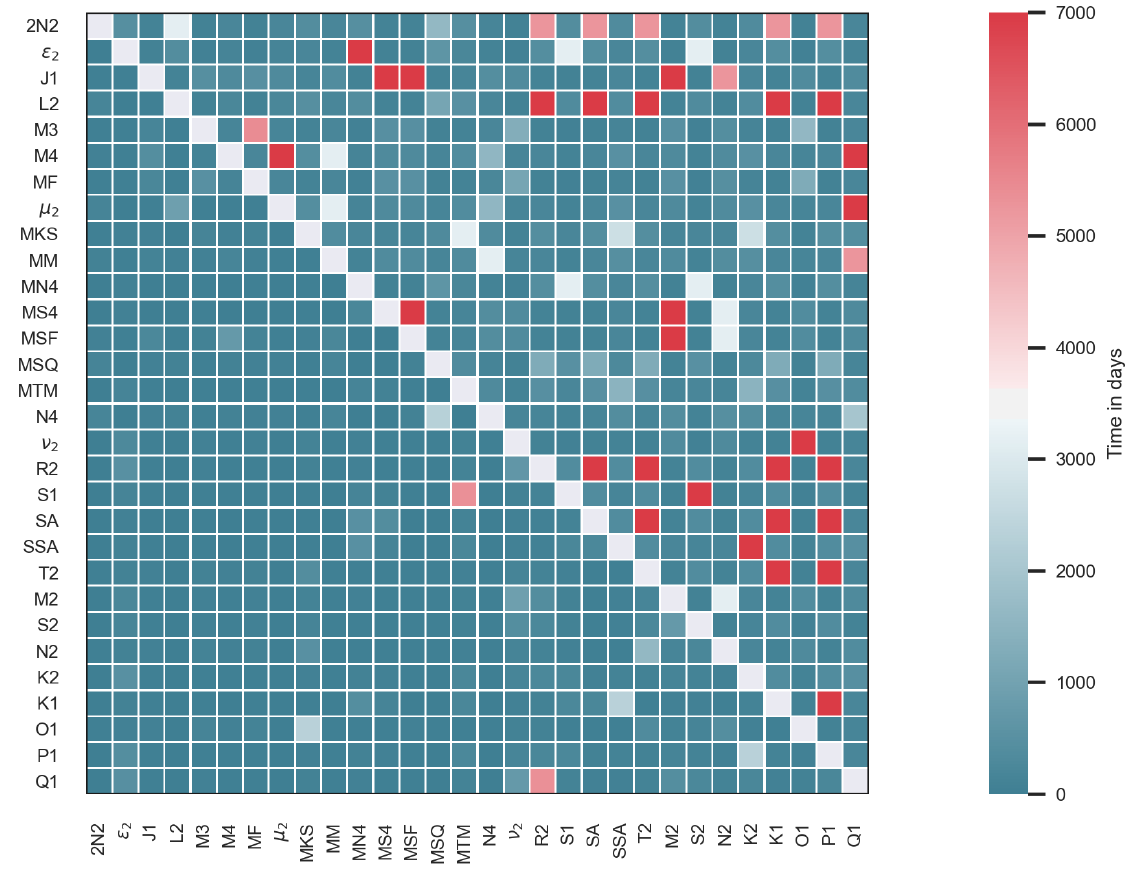
Figure 3. Rayleigh coefficient in days of the Jason orbit (lower-left corner) and the Envisat orbit (upper-right corner) missions. The maximum time in days seen in the colourbar is chosen to be the temporal extent of the Envisat orbit used in the EOT